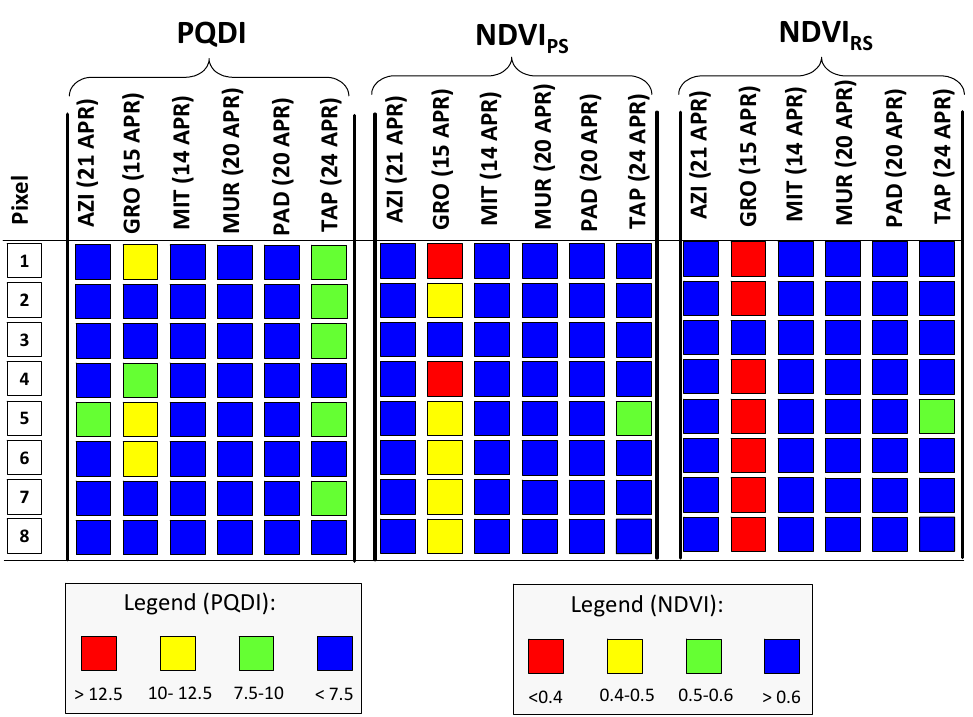
Figure 15. Example of spatial variability of pasture quality degradation index (PQDI) and normalized difference vegetation index (NDVI) obtained by proximal and remote sensing (PS and RS, respectively) within each experimental field in April 2020.